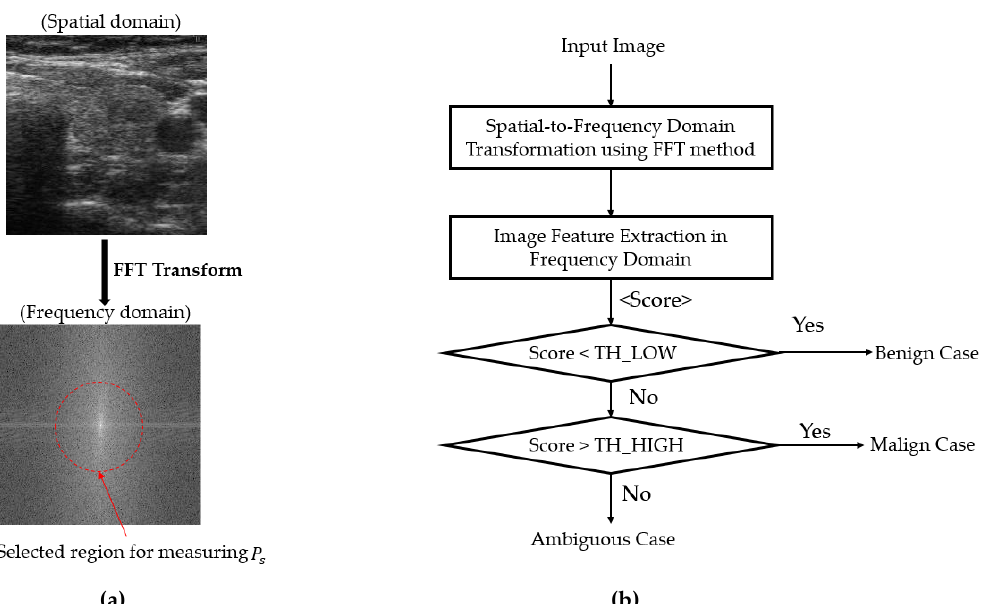
Figure 4. Coarse classifier based on information extracted in the frequency domain using the Fast Fourier Transform (FFT)-based method: ( a ) a thyroid image represented in spatial and frequency domain with a selected circle frequency regions and ( b ) the flowchart for classifying thyroid images into ‘benign’, ‘malign’, or ‘ambiguous’ region in our study.